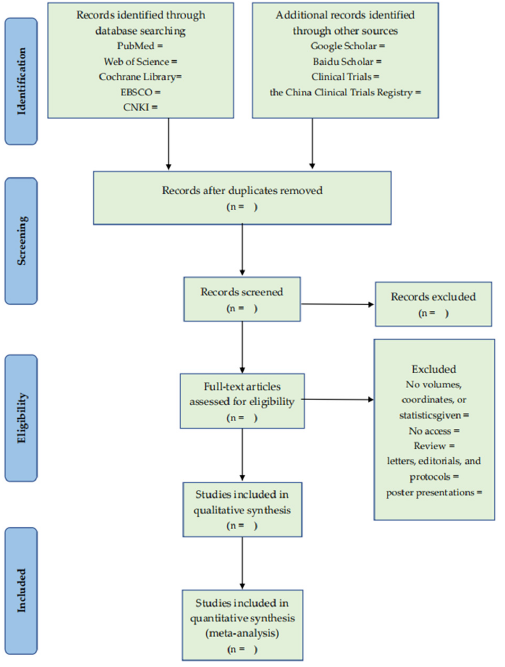
Figure 1. The PRISMA flow diagram of literature screening process.